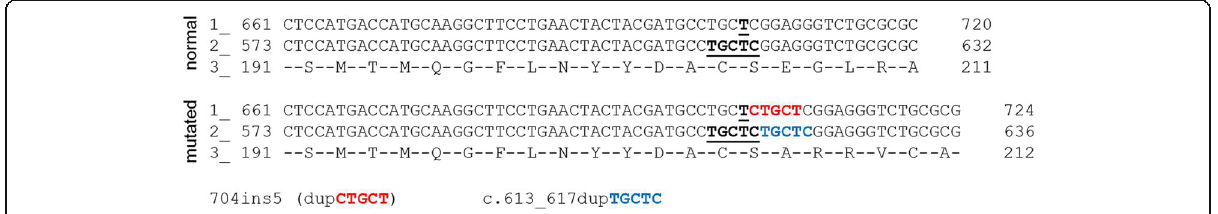
Fig. 1 Part of IDUA cDNA sequence obtained from Ensembl (www.ensembl.org, RefSeq NM_000203) highlighting mutation 704ins5/ c.613_617dupTGCTC. 1- Number refers to the nucleotide position considering number 1 as first nucleotide of cDNA (c.-88). 2- Number refers to the nucleotide position considering number 1 as the A from the first ATG (c.1). 3- Number refers to amino acid position considering number 1 as the first Methionine (p.M1). Black bold: positions 704 and 613_617 in line 1 and 2, respectively. Red: nucleotides inserted according to Yamagishi et al., 1996, when first describing mutation 704ins5. Blue: nucleotides duplicated in mutation c.613_617dupTGCTC. Both result in same nucleotide alteration, but were presented with different